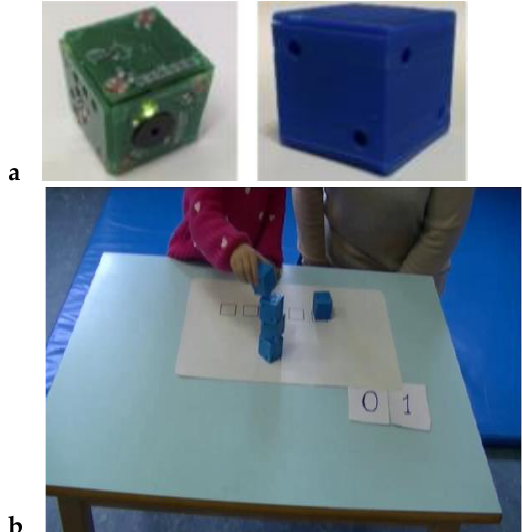
Figure 16. ( a ) Smart toys for detecting developmental delays in children, ( b ) child manipulates with smart cubes to build a tower [33].